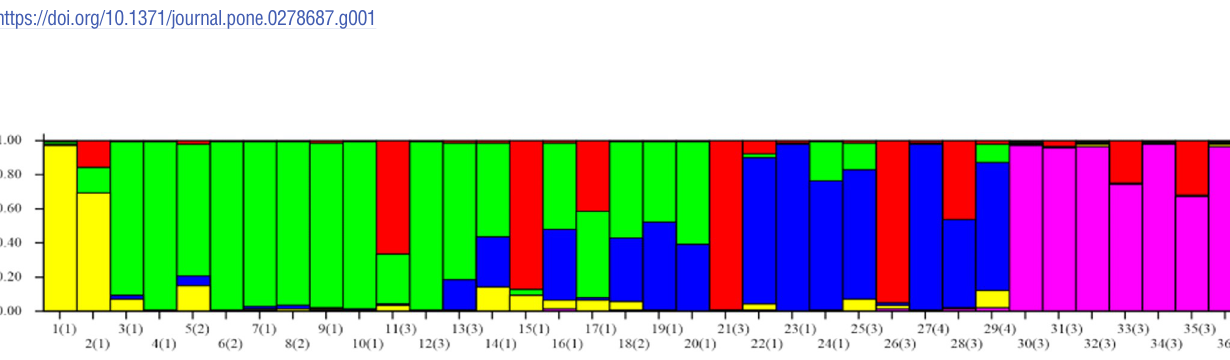
PLOS ONE | https://doi.org/10.1371/journal.pone.0278687 December7,